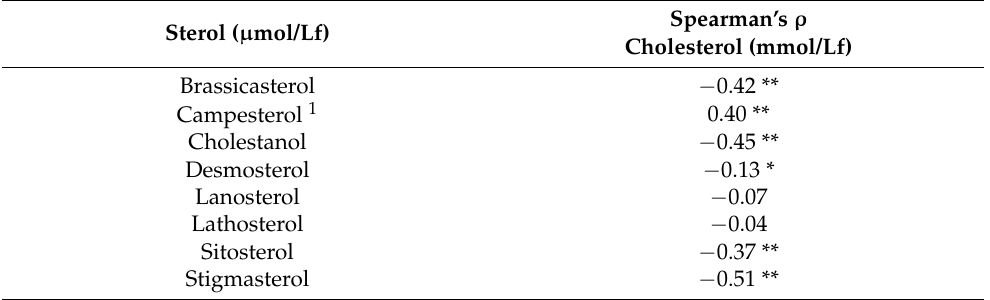
Table 7. Spearman correlations between cholesterol and non-cholesterol sterols, N = 311. Sterol ( µ